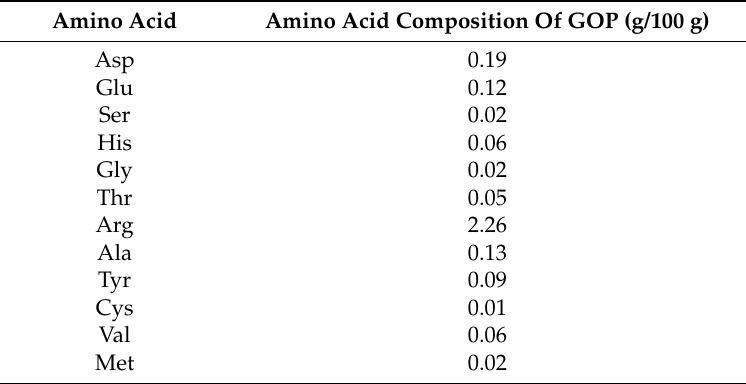
Table 1. Amino acid composition of